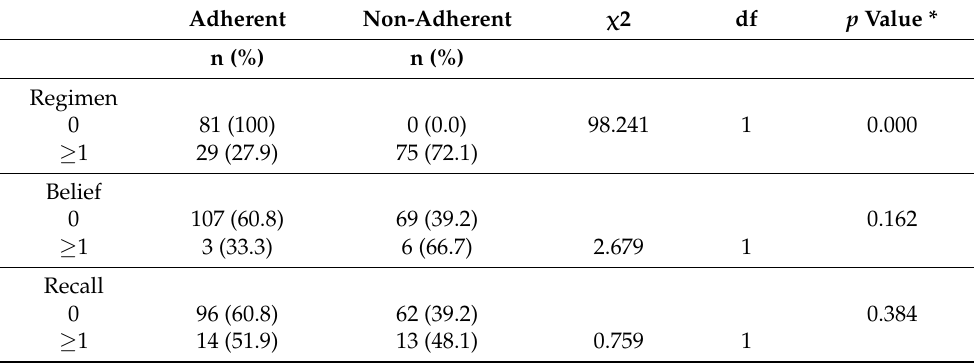
Table 5. The medication adherence to intranasal corticosteroids as evaluated by the Brief Medica- tion Questionnaire.